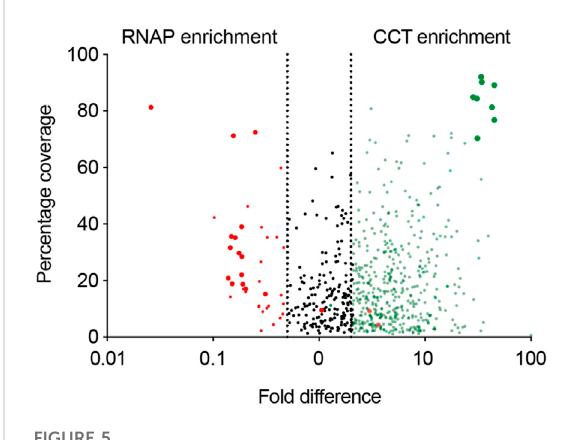
FIGURE 5 The CCT interactome volcano plot. The CCT interactome. A graph showing the difference in proteins pulled down using RNA polymerase(red)andtheCCTcomplex(green)againstpercentage coverage, as an indicator of abundance. Proteins between thetwodashedlines werediscarded, astheywerenotsigni fi cantly enriched in either sample (i.e., proteins with less than two-fold enrichment in either sample). RNA polymerase subunits (big red) and CCT subunits (big green) are highlighted.